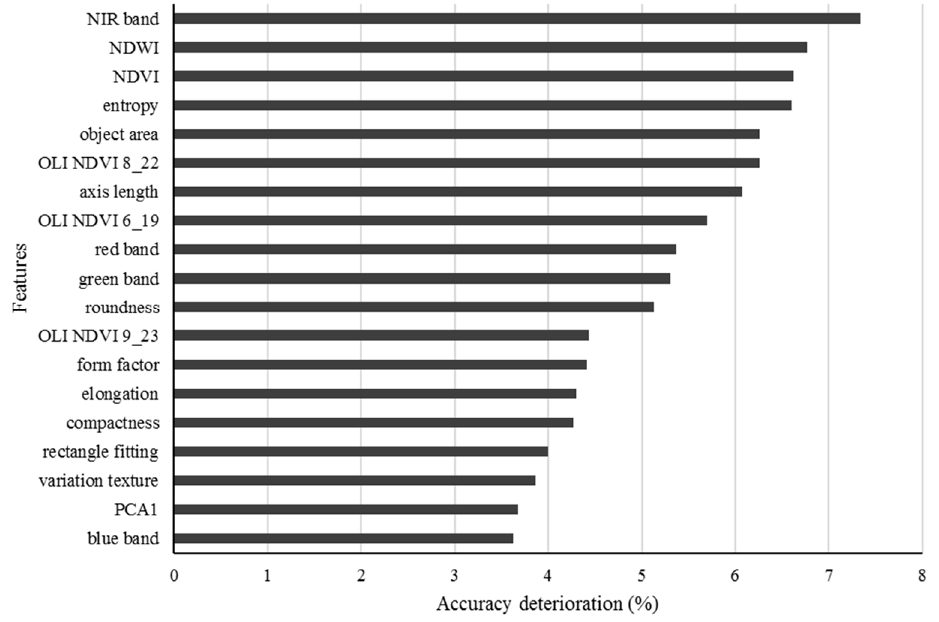
Figure 6. Relative contributions of the features to the classification.